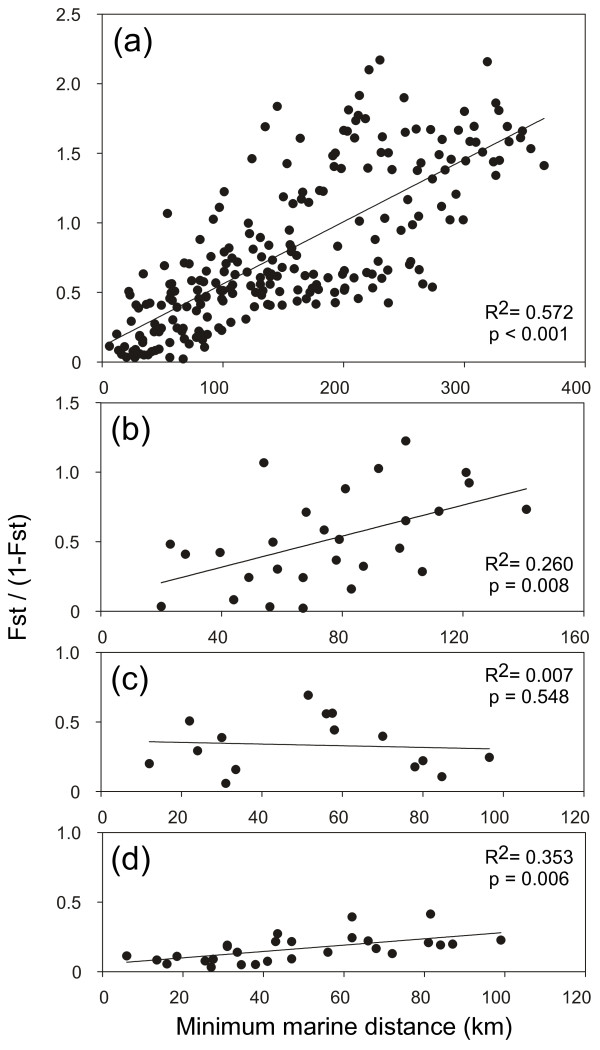
Isolation by distance in Fucus ceranoides from NW Iberia.  Estimates of pairwise differentiation (F ST/1-FST) are plotted against geographic distance for (a) NW Iberia (b) W sector, (c) NW sector and (d) N sector. The regressions are: y = 0,0045x + 0,1134), y = 0,0056x + 0,0934, y = −0,0006x + 0,3652 and y = 0,0023x + 0,0543, respectively.